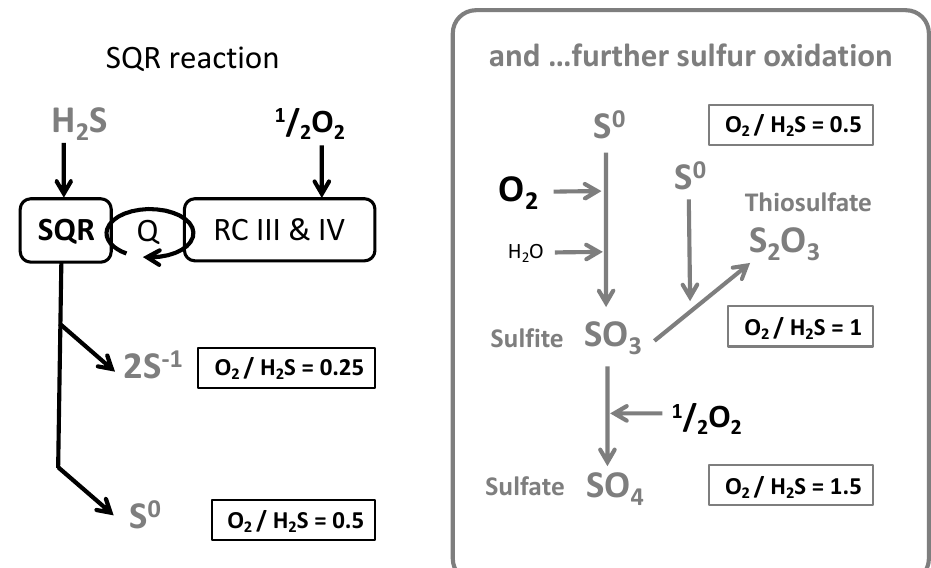
Figure 4. Oxygen consumption and sulfide oxidation. SQR yields two electrons and protons to the respiratory chain (RC III & IV), with the oxidation of one sulfide into S 0 or to two sulfides releasing two S − 1 . On the right (boxed), subsequent sulfur oxidation steps from S 0 . The respective O 2 /H 2 S ratios are indicated near the reaction products. Note that the oxygen consumption from sulfite to sulfate is explained by the activity of the respiratory chain.